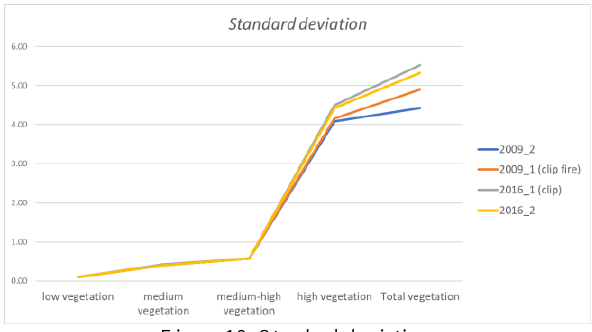
Figure 13. Standard